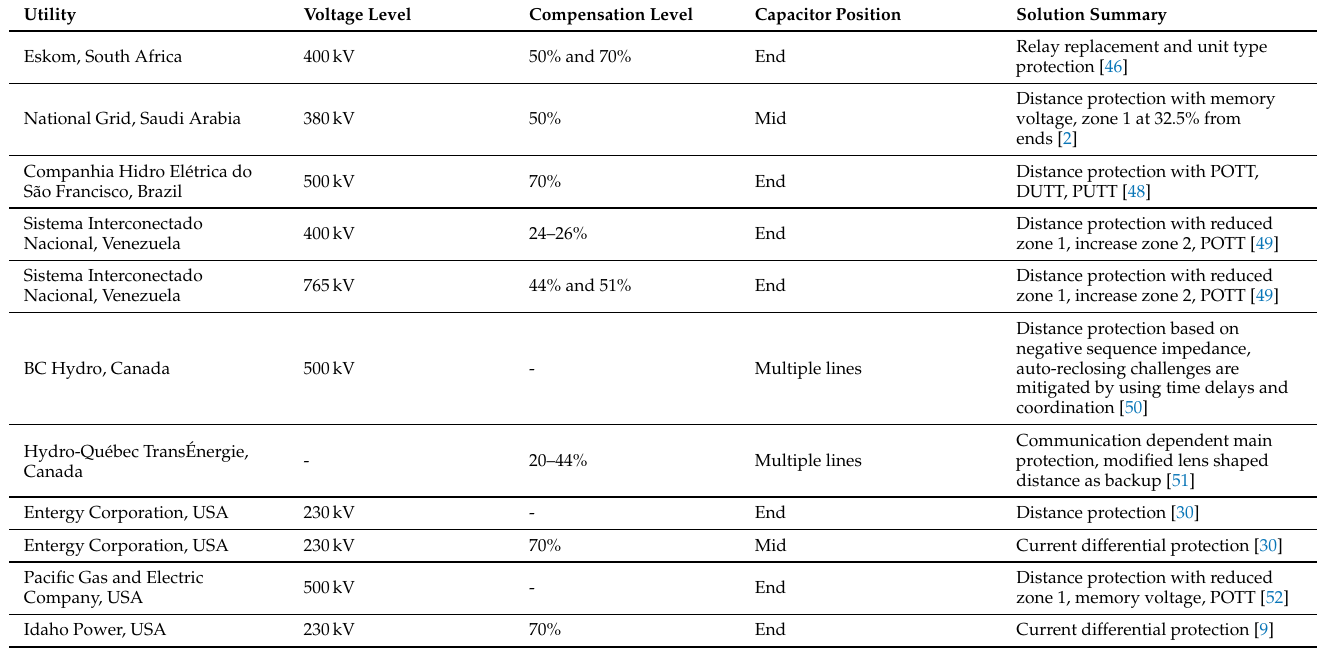
Table 1. Implementation examples.